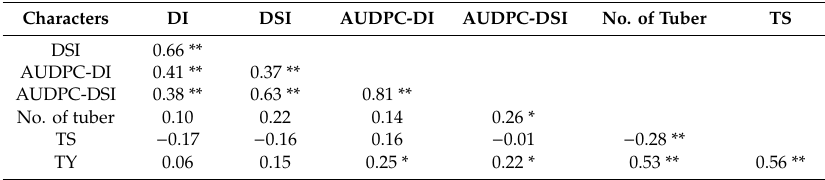
Table 7. Correlation coe ffi cients of DI, DSI, AUDPC-DI and AUDPC-DSI, number of tuber / plant (No. of tuber), TS (g / tuber), and TY (g / plant) of 96 Jerusalem artichoke varieties in early rainy.